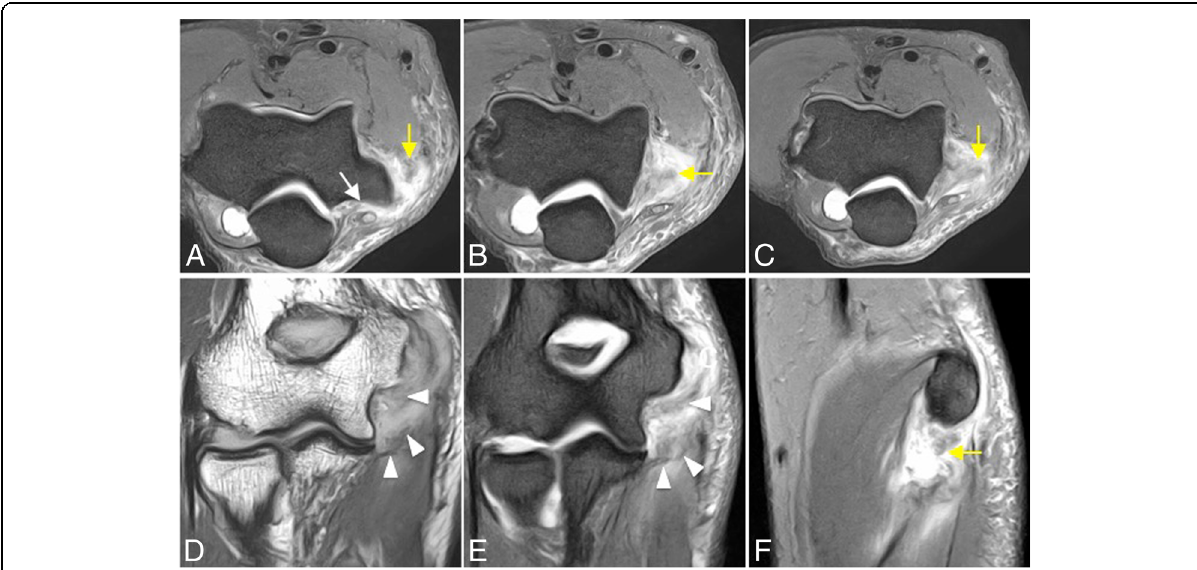
Fig. 36 Acute subluxation in a handball player with a history of medial instability treated with arthroscopic repair. Consecutive axial FS PD- weighted MRI ( a – c ), coronal T1-weighted MRI ( d ), coronal FS PD-weighted ( e ), and sagittal FS PD-weighted MRI ( f ) showing a re-tear of the repaired anterior bundle of the medial collateral ligament (white arrowheads), a complete tear of the common flexor tendon (yellow arrows), and a tear of the posterior bundle of the medial collateral ligament (white arrow)